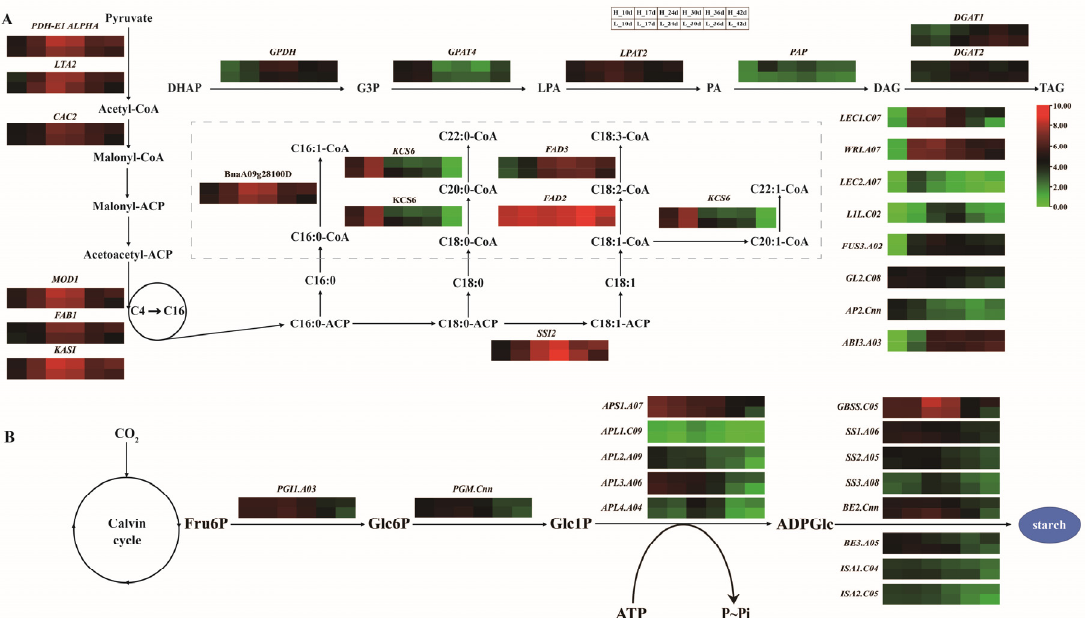
Figure 6. Expression of key genes in pathways of lipid metabolism ( A ); and starch metabolism ( B ). The colors correspond to the value of FPKM, ranging from green (low expression) to red (high ex- pression).